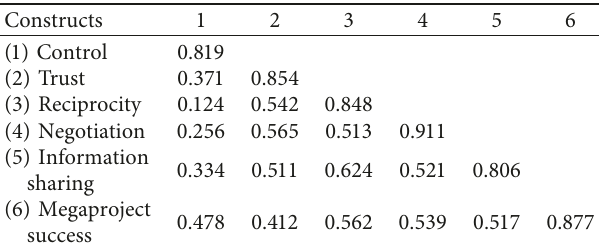
Table 4: Correlations of the constructs and the values of dis- criminant